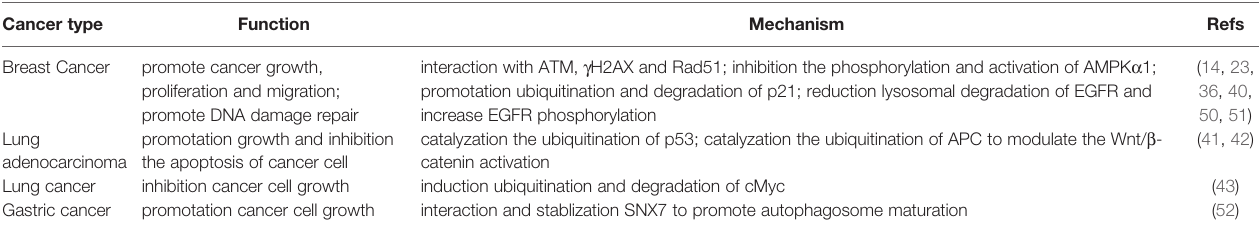
TABLE 2 | The functional roles of RNF115 in